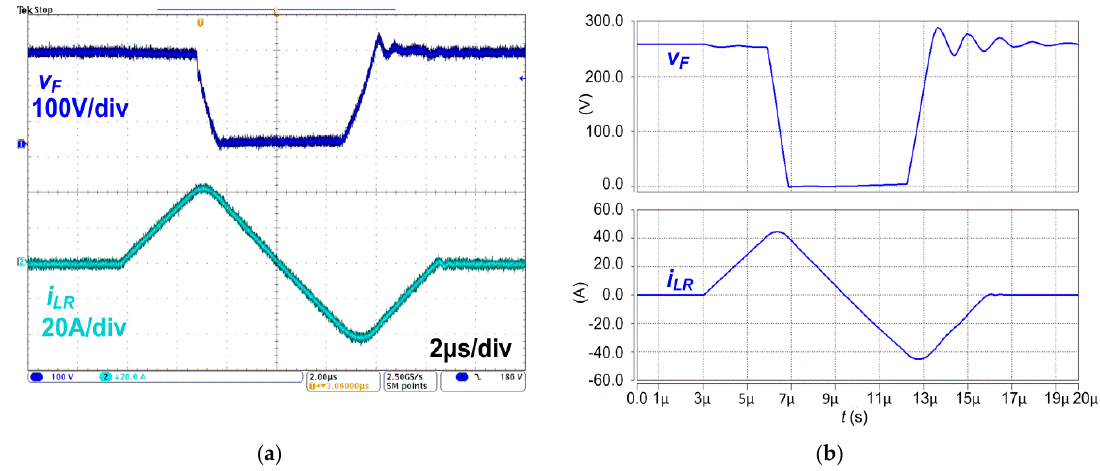
Figure 14. PQRDCLI Quasi-resonant voltage v F and current i LR waveforms at related output power (2 kW): ( a ) measurement; ( b ) simulation.